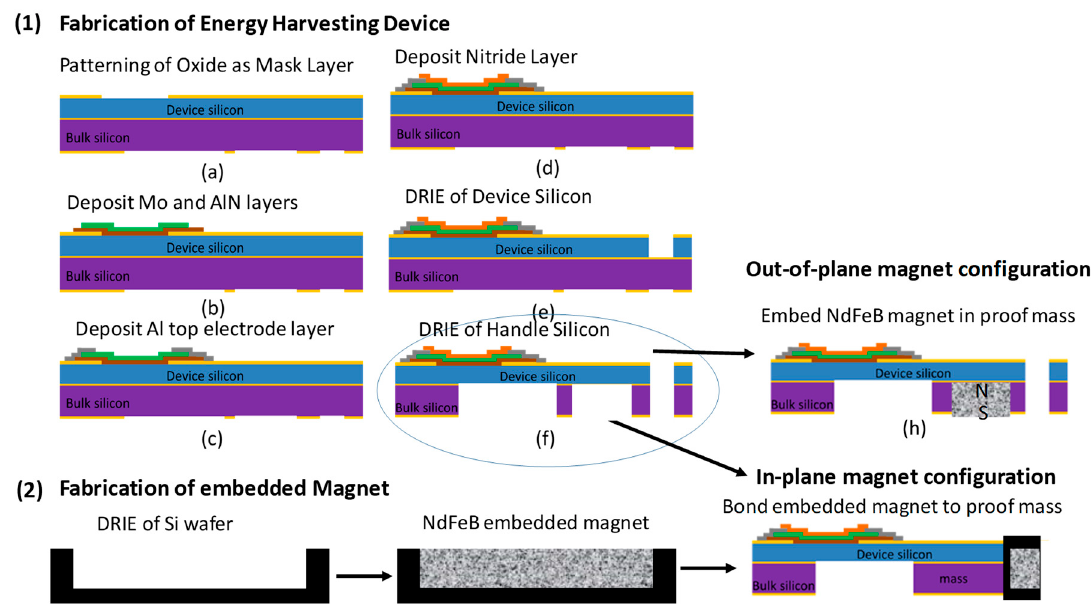
Figure 2. Fabrication of a ( 1 ) microelectromechanical system (MEMS) piezoelectric cantilever with embedded NdFeB magnets. Out-of-plane fabrication consisted of etching the cavity into the Si mass and embedding NdFeB powder capped with parylene. In-plane fabrication consisted of bonding a ( 2 ) silicon die with an embedded magnet on the end of the cantilever. AlN was used as the piezoelectric film.